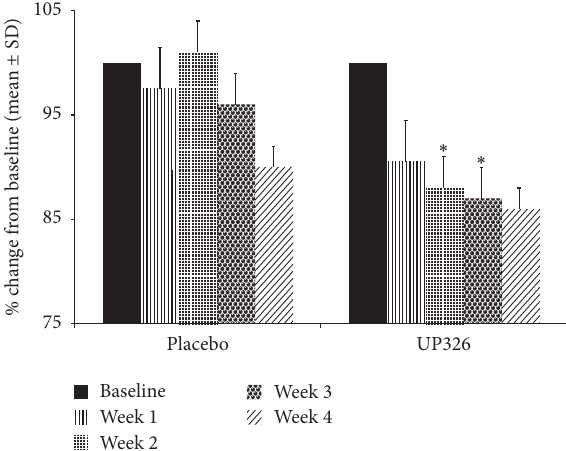
Figure4:WorkingmemoryspeedRTmedianshowedimprovement from baseline to week 4. Relative to group A placebo, a significant improvement in working memory processing efficiency seen for groups B (UP326) in weeks 2 and 3 of treatment ( ∗ 𝑝 < 0.05 ).